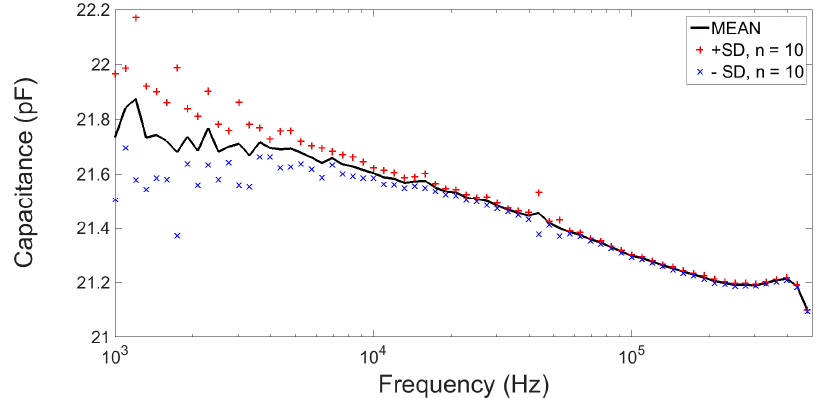
Figure 9. Capacitance profile for a 500 nm vertical nanogap device filled with air for the frequency range 1 kHz to 500 kHz.